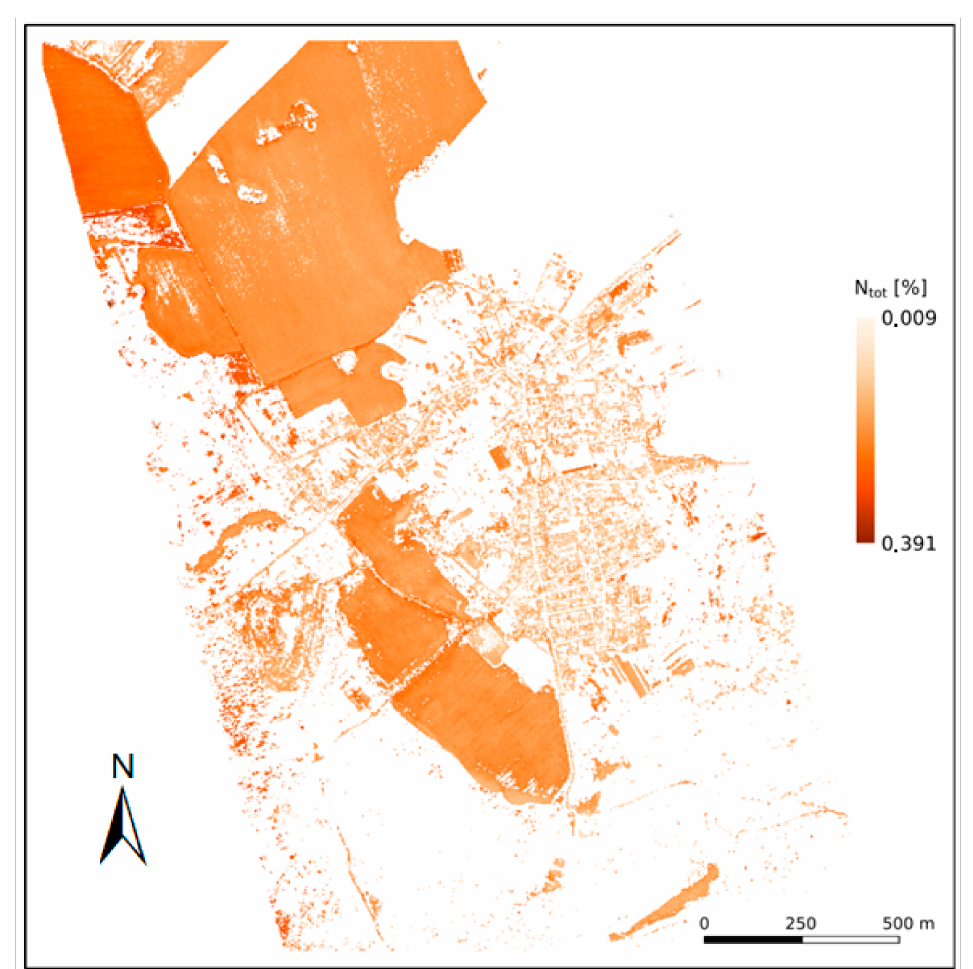
Figure 9. Sample of total soil nitrogen raster output, which contains predicted values for total soil nitrogen (Ntot) from 8 November